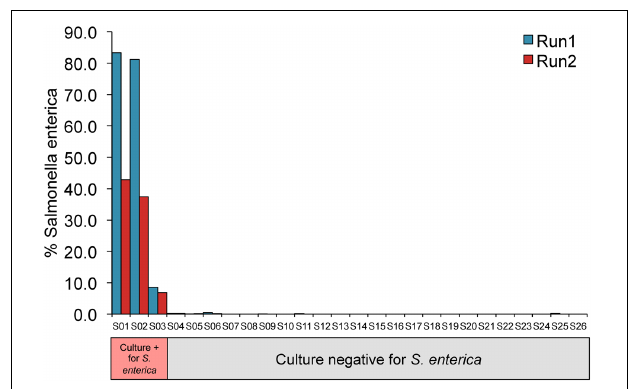
FIGURE 4 | 16S rRNA profiling of blood samples are consistent with Salmonella culture results. Y -axis displays percentage of total sequences assigned to S. enterica